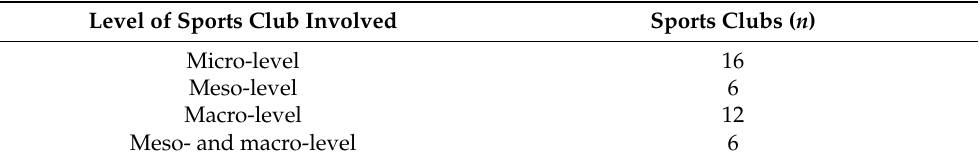
Table 4. Levels of the sports club involved in providing the sporting program six and a half years after a funding